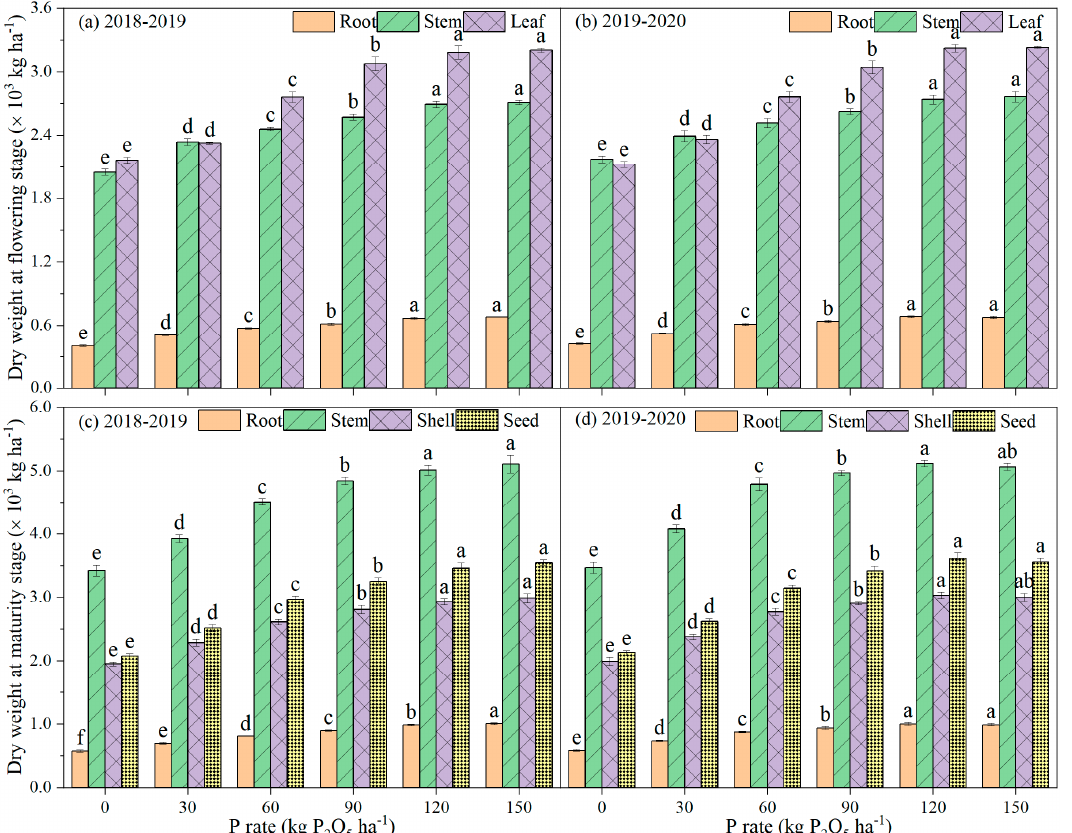
Figure 1. Effects of P rate on biomass accumulation of canola plants in saline environment. ( a , b ): biomass accumulation at flowering stage during 2018–2019 and 2019–2020 growing seasons. ( c , d ): biomass accumulation at maturity stage during 2018–2019 and 2019–2020 growing seasons. Different letters indicate significant difference at p = 0.05 between P rate treatments for the same plant organ.